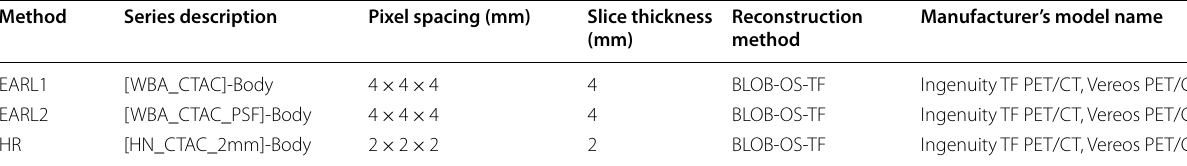
Table 1 Summary of parameters characterizing each reconstruction method